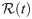
Reproduction function in Emilia-Romagna.
ℛ(t) predicted until 24/06/2020 after the calibration of fSEIRDe (red continuous line) and fSEIDRr (blue dash-dotted line) on the data in the period [24/02-27/03].